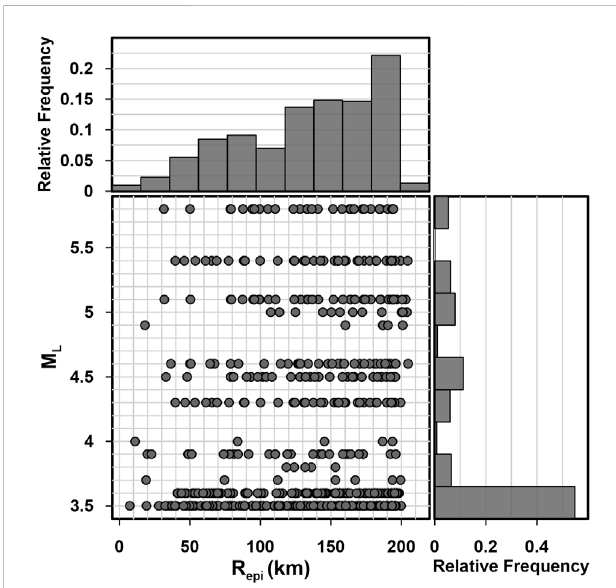
FIGURE 2 Distribution of the local magnitude ( M L ) and epicentral distance (R epi ) of ground motions recorded at the second-level sensors during 2000 – 2018 by the KMA network.